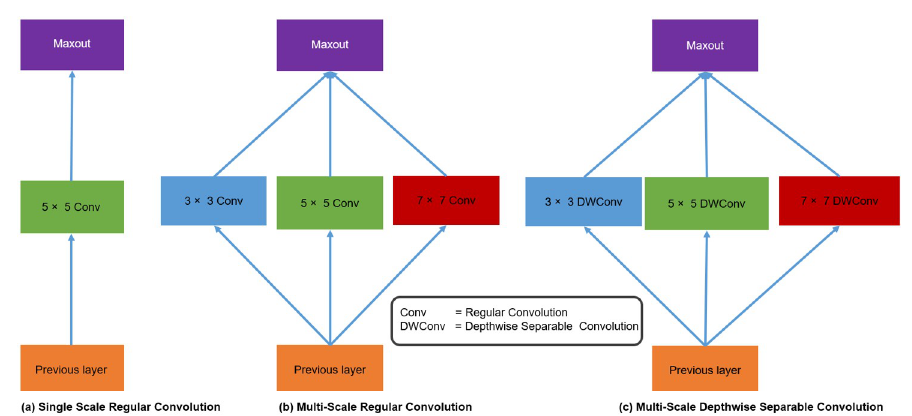
Fig 3. Comparison of a single scale, multi-scale regular and depthwise separable convolution blocks. (a) Single Scale Regular Convolution (b), Multi-Scale Regular Convolution, and (c) Multi-Scale Depthwise Separable Convolution (Our